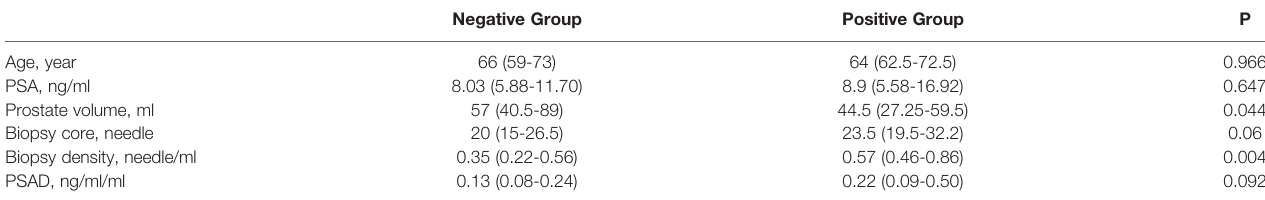
TABLE 1 | Comparison of baseline information of patients in the biopsy-positive and negative groups.